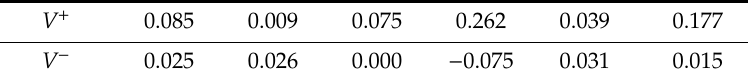
Table A9. Full calculations of the successfulness TOPSIS.